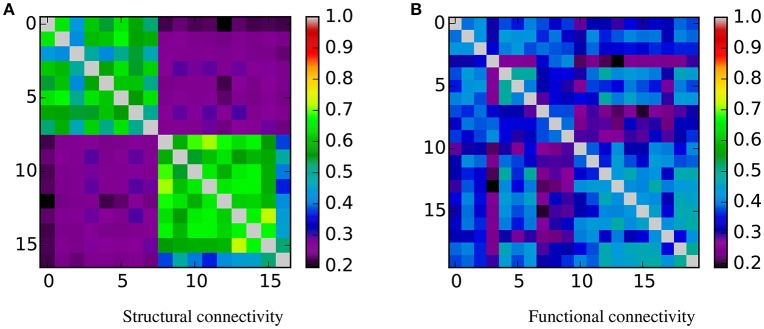
Similarity matrices. Rows and columns are organized by class, first the BTBR samples, and then the B6. In the case of structural connectivity, it is clear that samples from the same class are similar between them and dissimilar to the samples from the other class. For the functional connectivity this pattern is not evident. (A) Structural connectivity. (B) Functional connectivity.